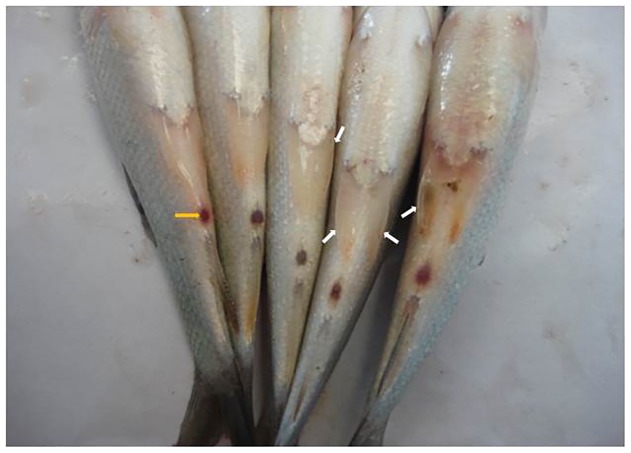
Fish injected with pathogenic bacteria Aeromonas hydrophila showing one or more typical signs of infection according to the stage of disease.Signs included hemorrhagia (large and irregular hemorrahages), shallow to deep necrotizing ulcers, and abdominal distension with sero-hemorrhagic fluids exuded from the inflamed vent. White arrows indicate edges of the ulcers. A yellow arrow indicates vent. Abdominal distension is clear in the right side fish. All fish shown are infected.